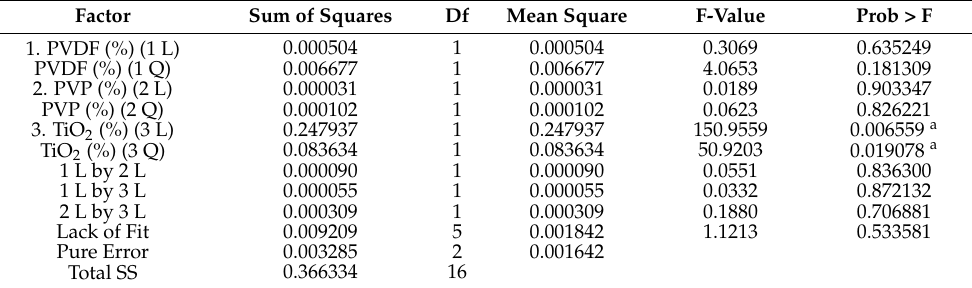
Table 9. Analysis of variance of initial reaction rates (r) at the natural pH of methyl orange. R 2 = 0.9659; Pure error = 0.0016424. (L) is the linear relation, (Q) is the quadratic relation of the factors, and Df is the degrees of freedom of the